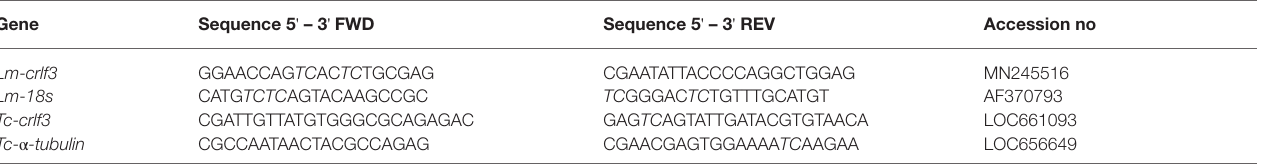
TABLE 1 | Oligonucleotides used in this study.